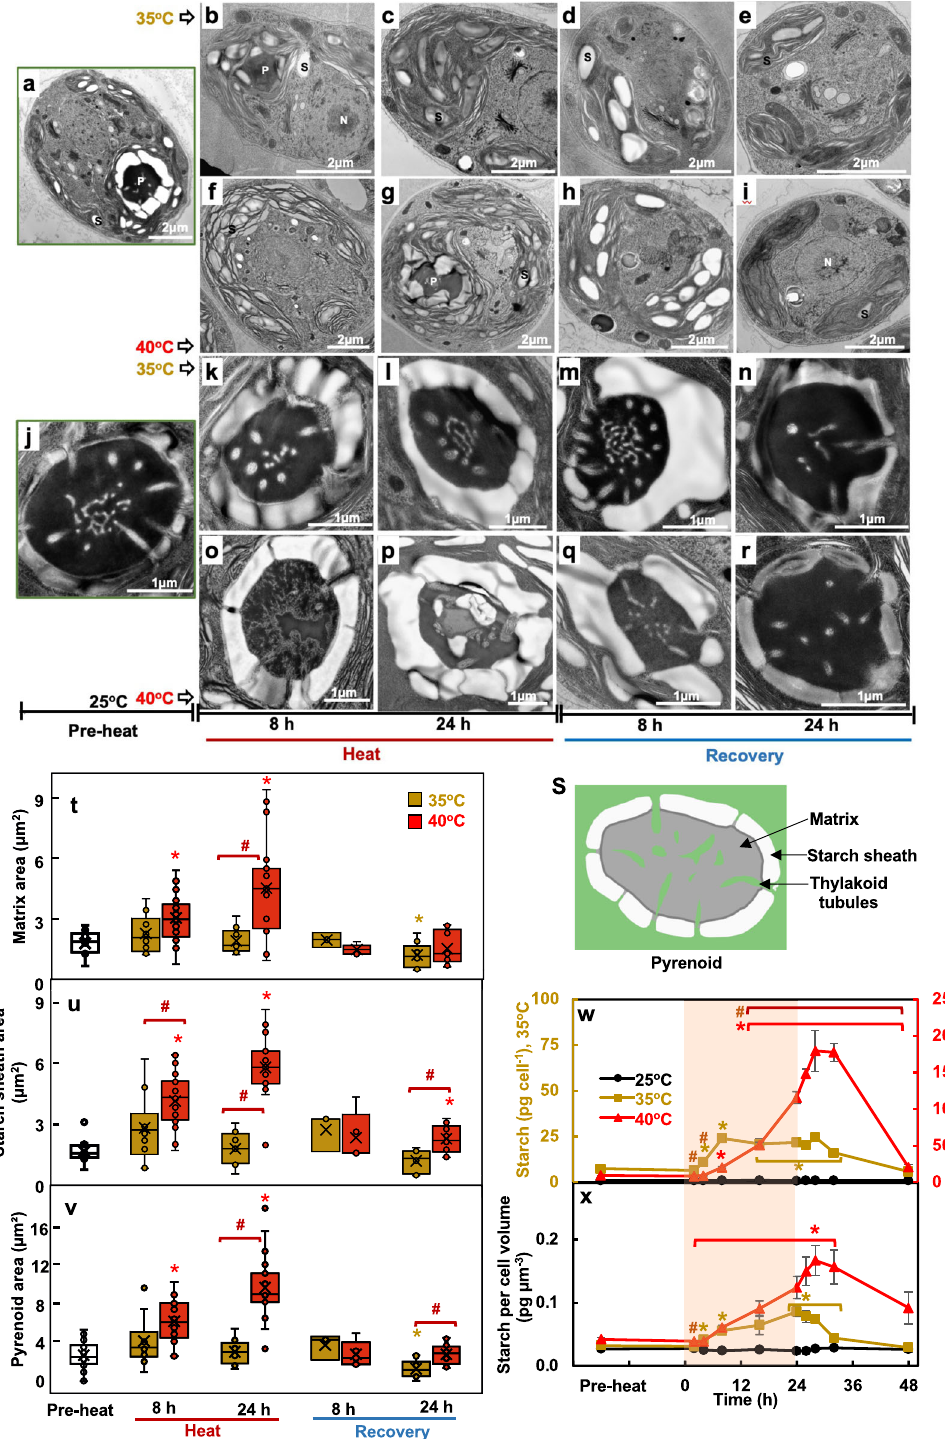
Fig. 9 Only 40°C altered thylakoid and pyrenoid ultrastructure while both 35°C and 40°C treatments stimulated starch accumulation. a – r Representative transmission electron microscopy (TEM) images of algal cells or pyrenoids at different time points before ( a , j ), during, and after heat treatment at 35°C ( b – e , k – n ) or 40°C ( f – i , o – r ). s Cartoon representation of Chlamydomonas pyrenoid structure. t , u , v Areas of pyrenoid matrix, starch sheath and the whole pyrenoids, respectively, quanti fi ed using ImageJ and TEM images from algal samples harvested before, during, and after heat treatments of either 35°C (brown) or 40°C (red) at the indicated time points. The data is presented as boxplot based on Tukey-style whiskers. Median values are represented by the horizontal black lines and mean values by the X sign inside each rectangular box. w , x Starch quanti fi cation using starch assay kits. Values are mean±SE, n = 3 biological replicates. The red shaded areas depict the duration of the high temperature. t – x Statistical analyses were performed using two-tailed t-tests assuming unequal variance by comparing treated samples with pre-heat ( t – v ) or 25°C at the same time point (w, x) (*, p <0.05, the colors of asterisks match the treatment conditions), or by comparing samples between 35°C and 40°C at the same time point (#, p <0.05). ( w , x ) P values were corrected by FDR.